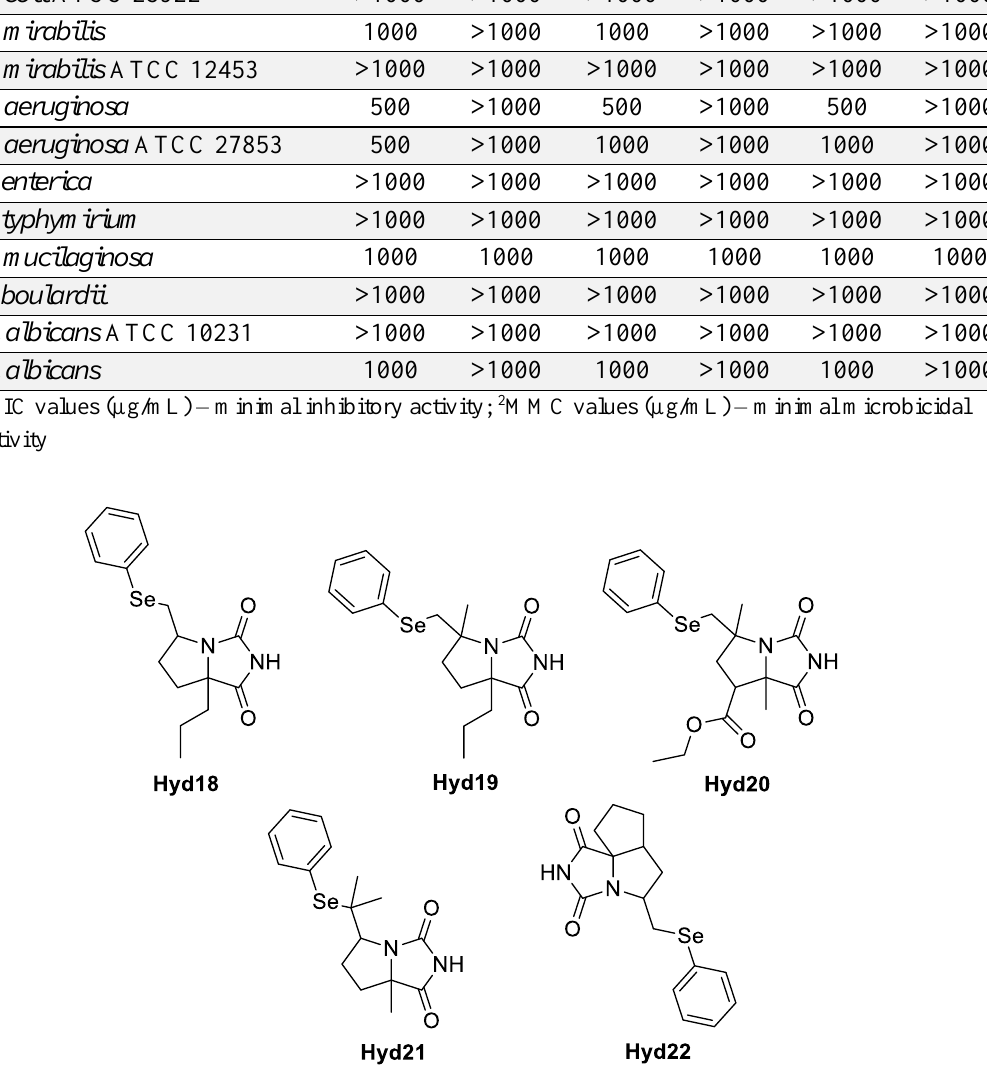
Figure 5. Bicyclic and tricyclic phenylseleno hydantoin